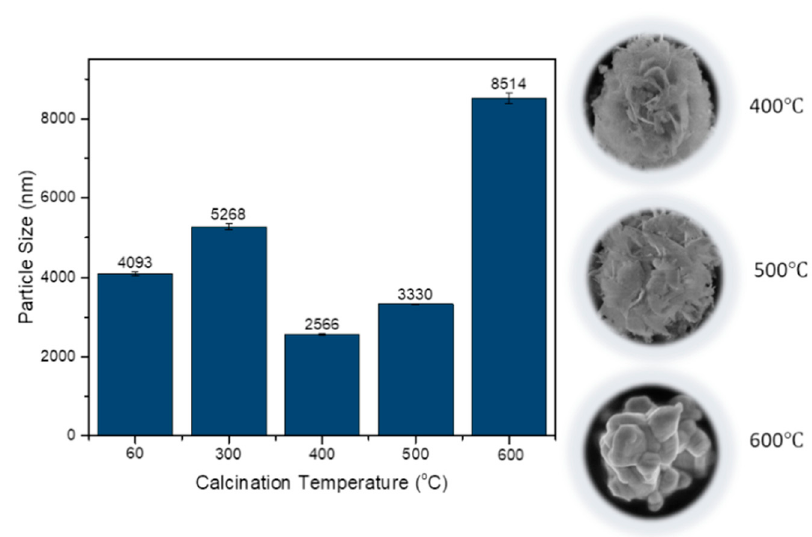
Figure 6. Particle size analysis of BiVO 4 microspheres under calcination temperatures of 60 °C, 300 °C, 400 °C, 500 °C and 600 °C.